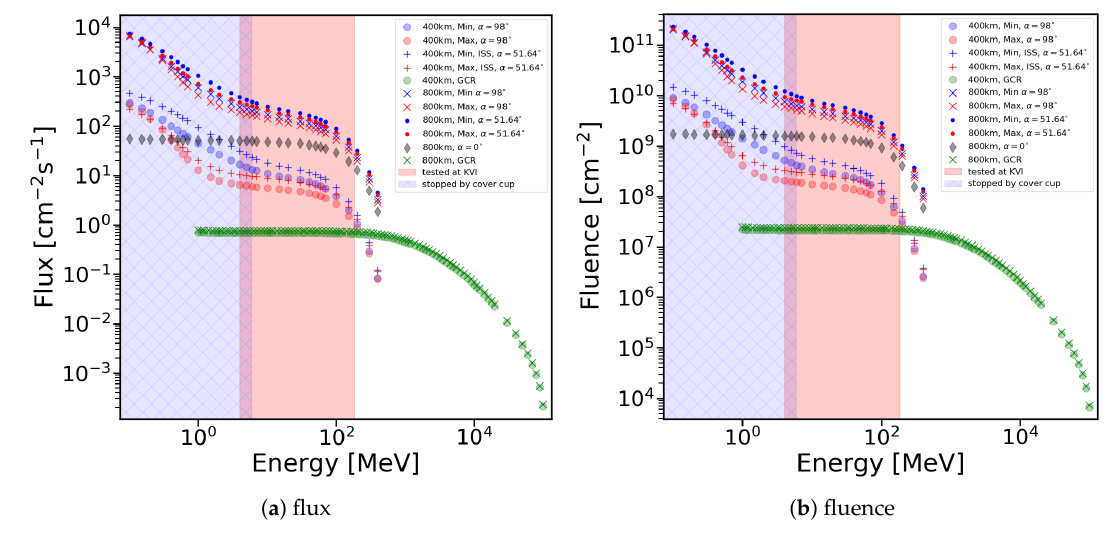
Figure 3. Integral flux and fluence